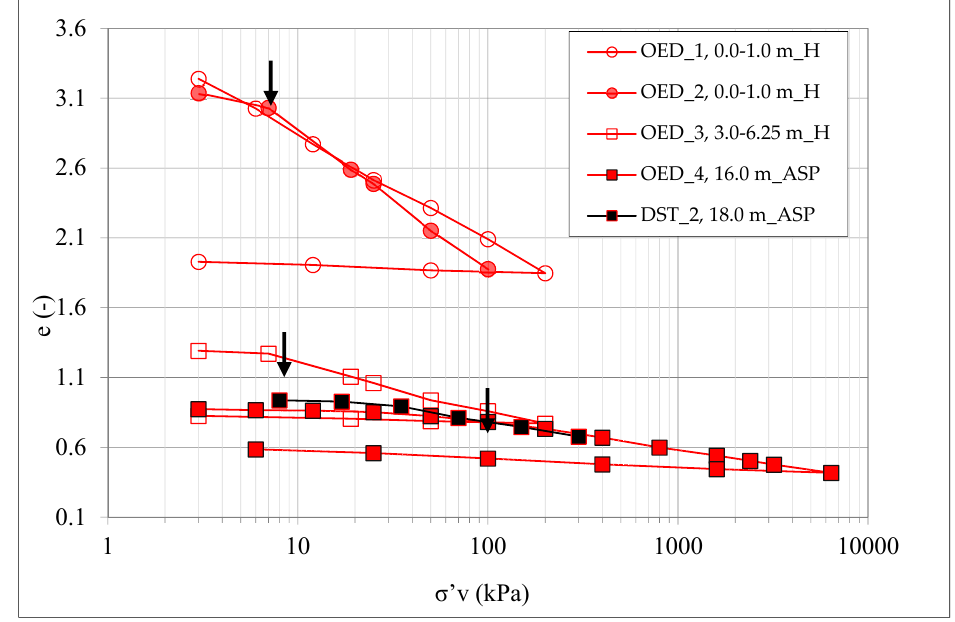
Figure 7. Compression curves of samples collected at different depths along borehole A3. ([42], modified). The arrows in the figure indicate the vertical effective stress at yield, σ ’ y .